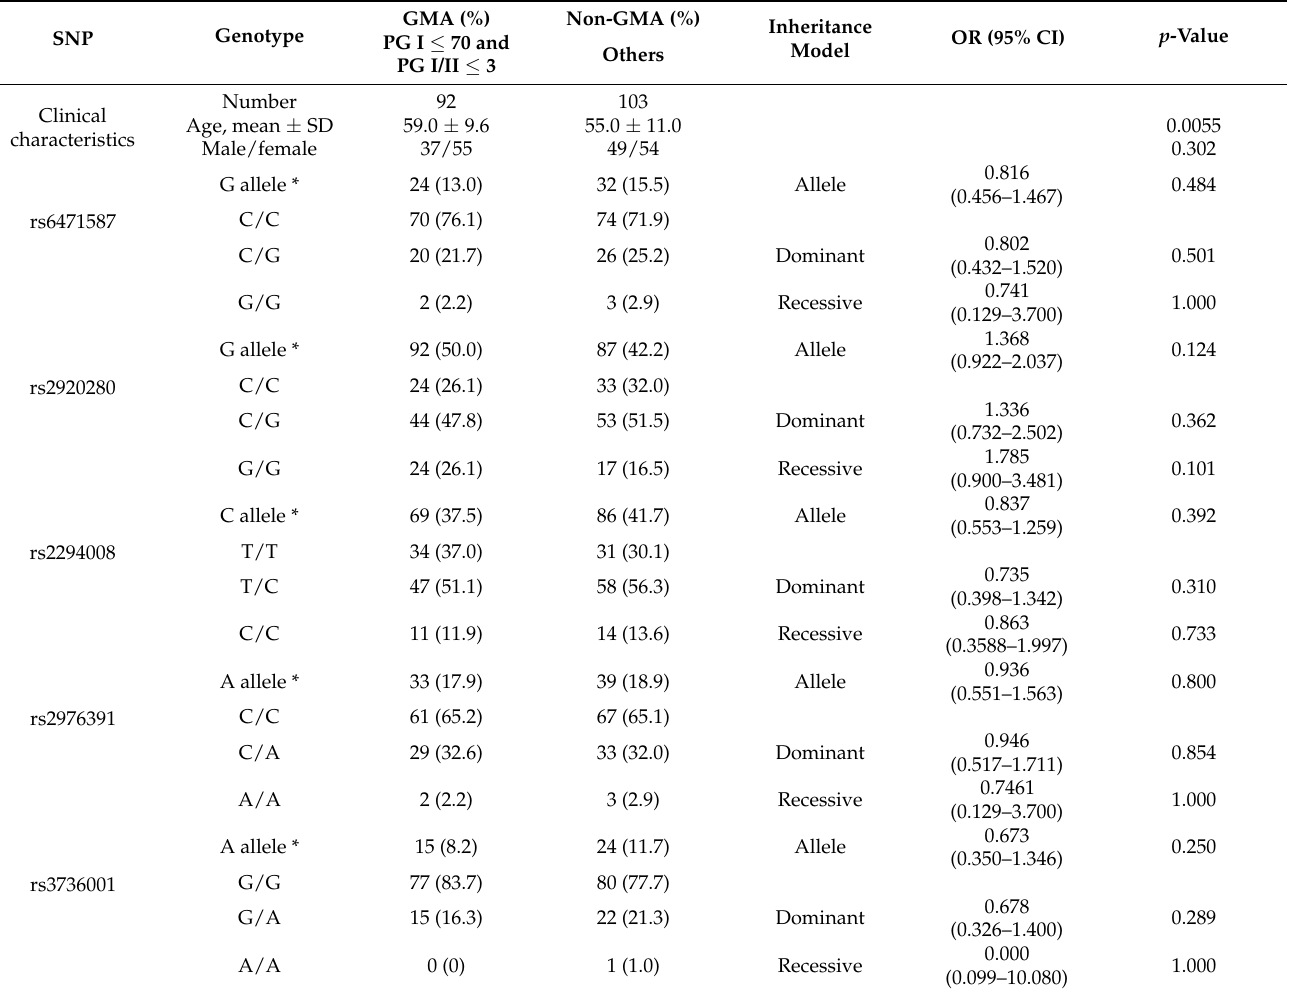
Asterisks indicate the number of minor alleles of each SNP but not genotypes. Abbreviations: SNP, single- nucleotide polymorphism; PSCA , prostate stem cell antigen; GMA, gastric mucosal atrophy; PG, pepsinogen; OR, odds ratio; CI, confidence interval; SD, standard